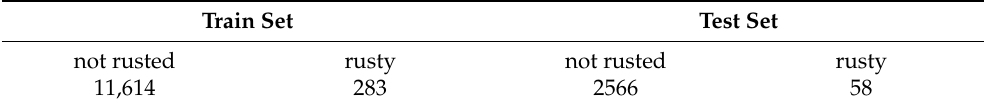
Table 2. Distribution of the original clamp